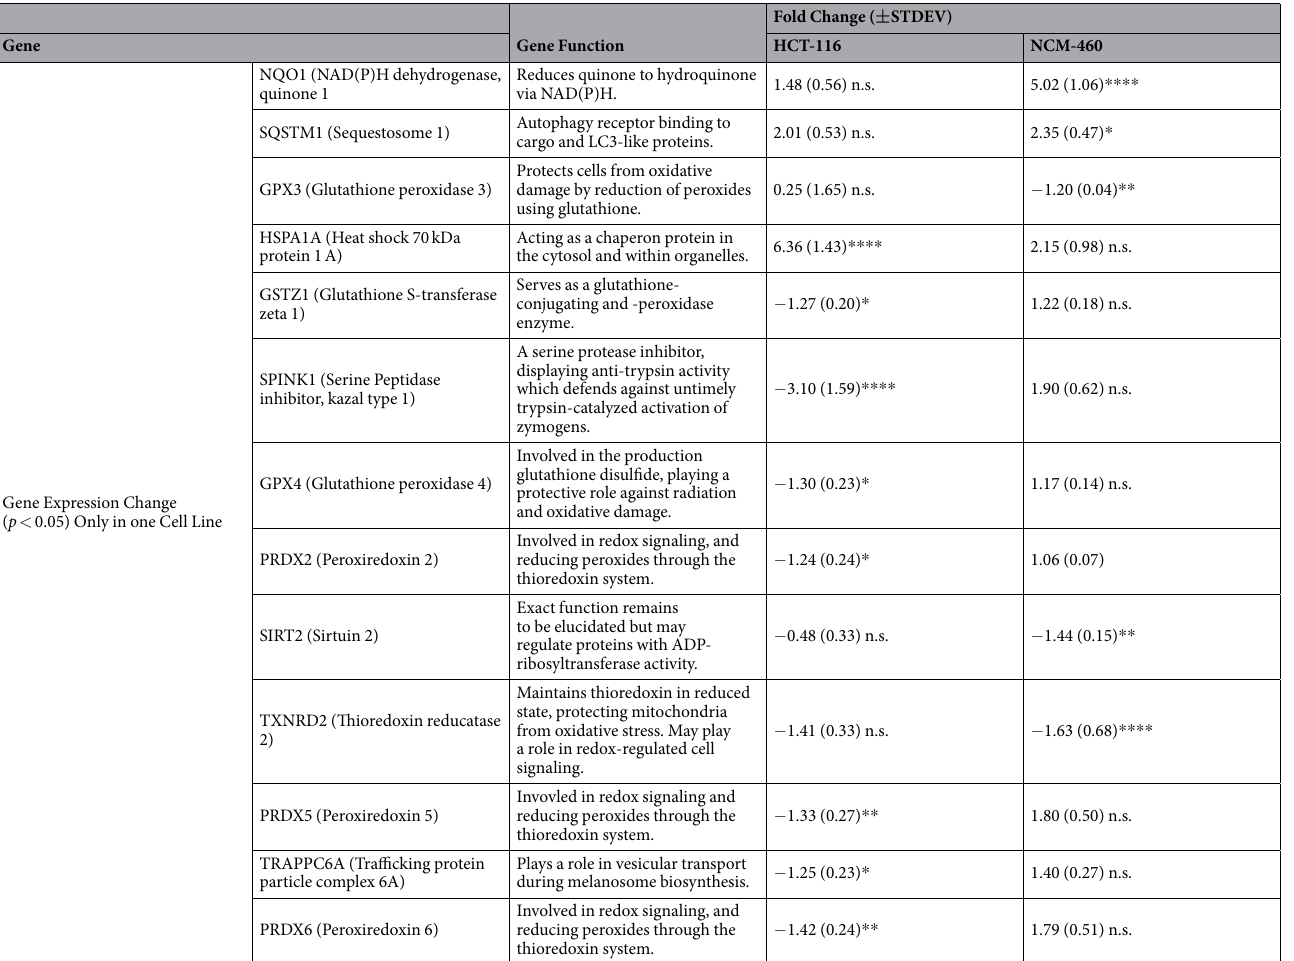
Table 4. Summary of the Relative-Fold Change in Gene Expression Utilizing RT 2 PCR. Statistical analysis was performed using One-Way ANOVA to relative-fold change of the control (1). * p < 0.05 vs control; ** p < 0.01 vs control; *** p < 0.001 vs control; **** p < 0.0001 vs control. n.s. = not significant, p > 0.05 vs control. N/A = not applicable due to no amplification detected. Gene function was obtained searching the UniProt or NCBI Gene D a t a b a s es